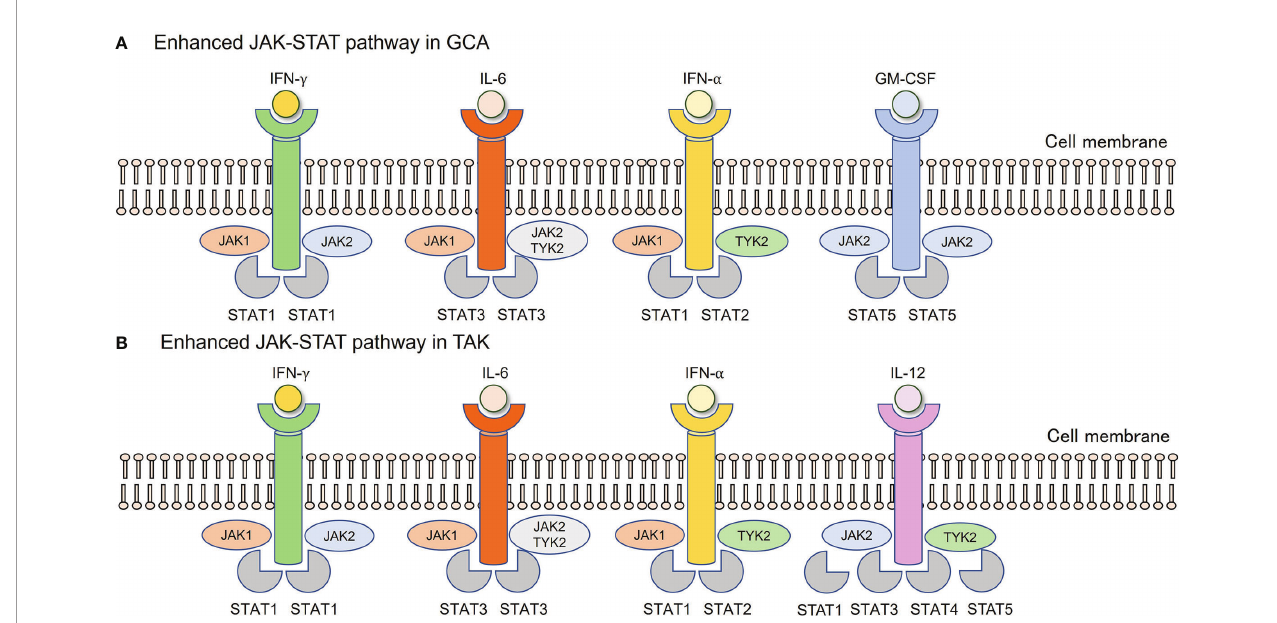
FIGURE 2 | Enhanced JAK-STAT pathway in GCA and TAK. (A) In vascular lesions of GCA, IFN- g derived from Th1 cells, IL-6 from tissue macrophages, IFN- a , and GM-CSF derived from unknown origin are enriched. (B) In vascular lesions of TAK, IFN- g derived from Th1 cells, IL-6 from tissue macrophages, IFN- a from unknown origin, and IL-12 from monocyte/macrophages are enriched. Each cytokine utilizes its JAKs, followed by corresponding STAT phosphorylation. GCA, Giant cell arteritis; GM-CSF, Granulocyte macrophage colony-stimulating factor; IFN, Interferon; JAK, Janus kinase; STAT, Signal transducer and activation of transcription; TAK, Takayasu